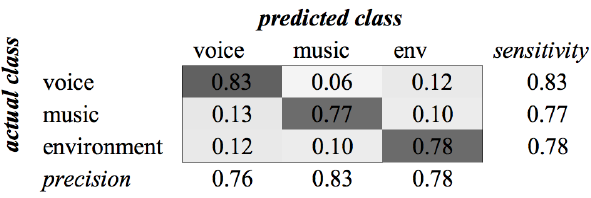
Figure A1. SVM confusion matrix of category Global for MFCC feature type.